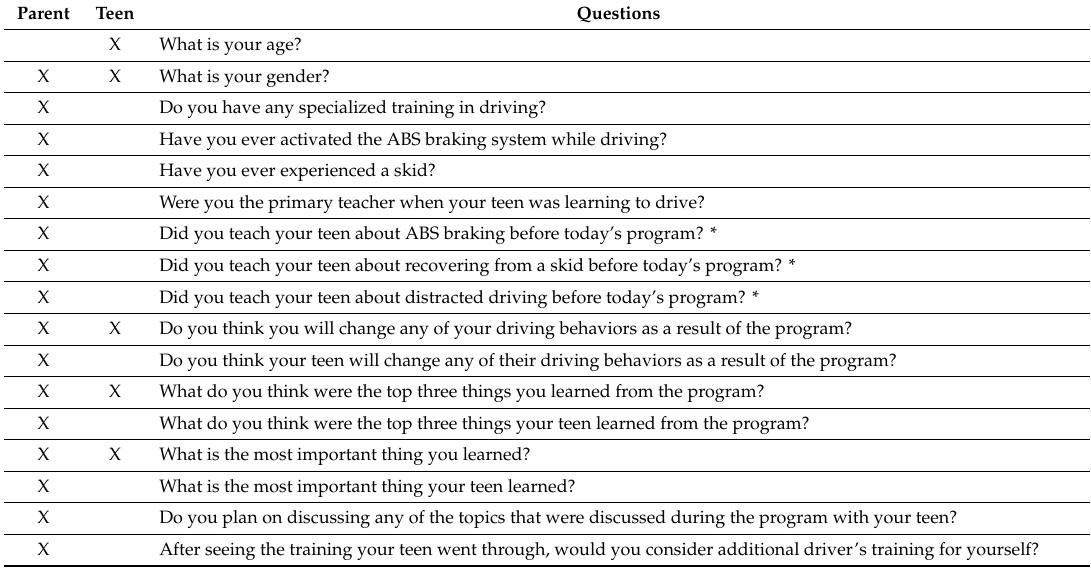
Table 1. Parent and teen survey